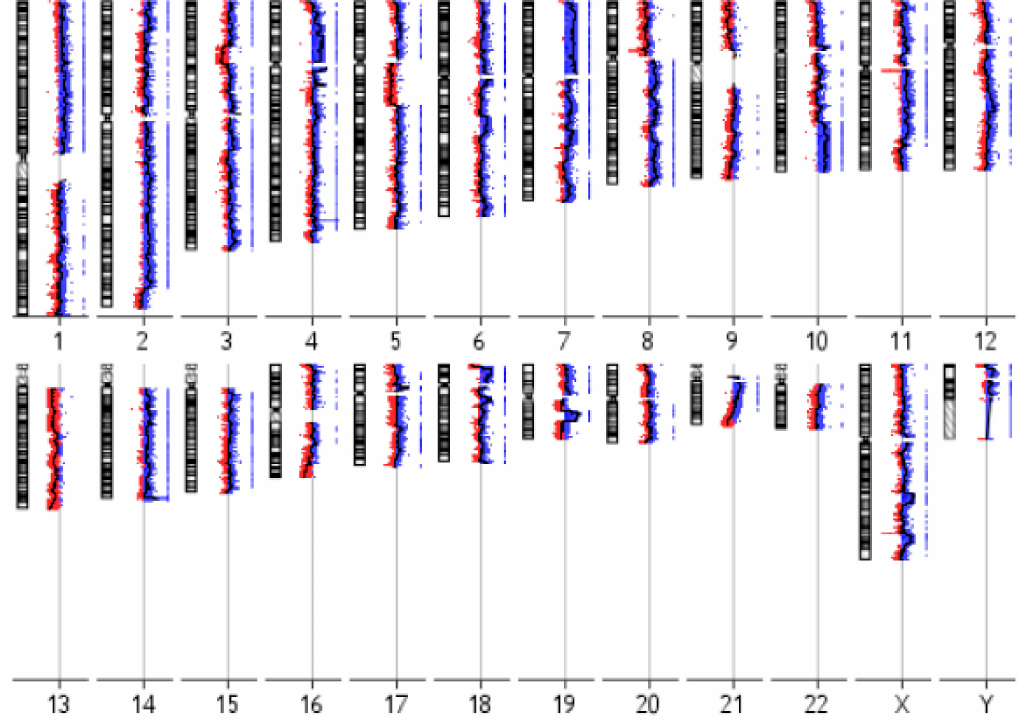
Figure 4. CGH profile of IM-MFS-1. Overview of chromosomal cytogenetic alterations in IM-MFS-1 cell line at passage 50. Gain and amplification alterations are shown in blue, while loss and deletions are shown in red. Table 1. Cytogenetic alterations on chromosome regions that contain candidate genes involved in cancer